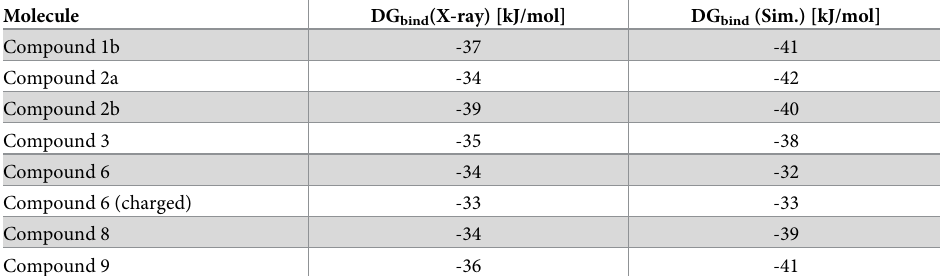
Table 1. The calculated binding free energies for the compounds docked either to the X-ray structure or the simu- lated structure of LCAT (after 1 us). Molecule DG bind (X-ray) [kJ/mol] DG bind (Sim.)